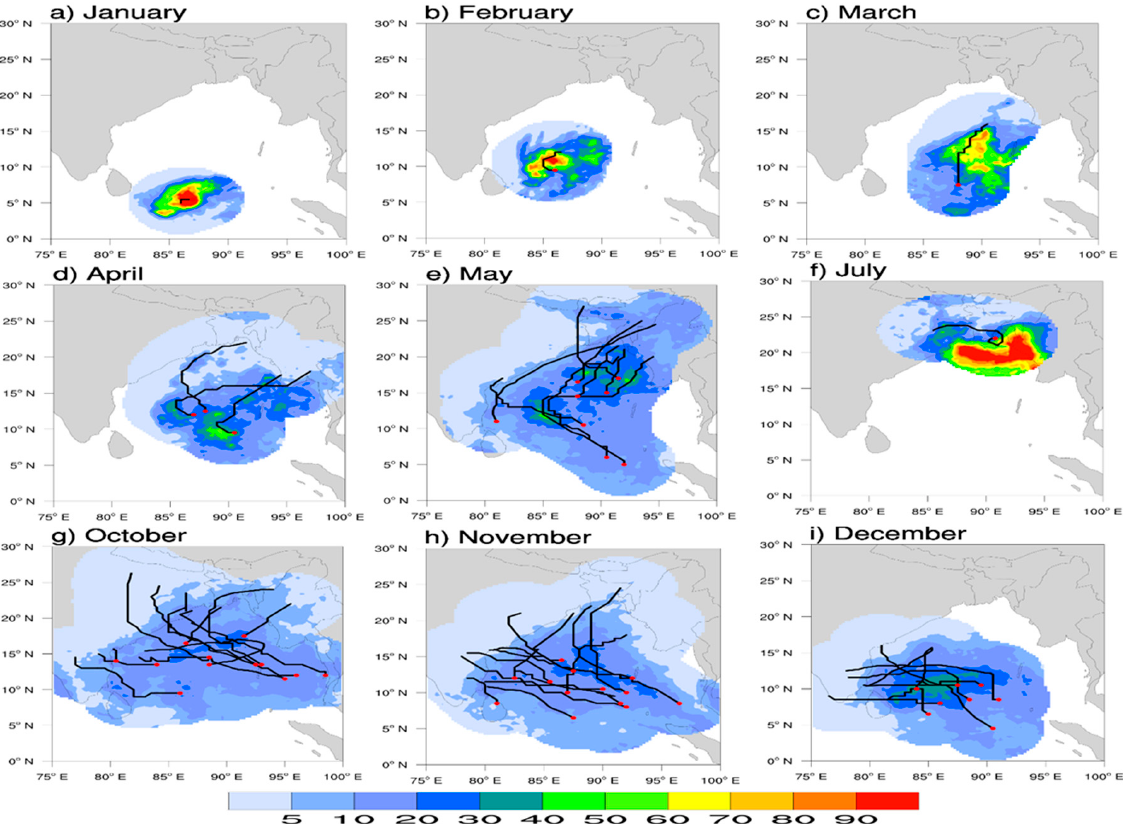
Figure 9. Monthly accumulated TC rainfall (mm) from January to December. The months June, August, and September were omitted because there was no TC activity in these months. The red circle indicates the genesis point of TCs. ( a ) January, ( b ) February, ( c ) March, ( d ) April, ( e ) May, ( f ) July, ( g ) October, ( h ) November, ( i ) December.